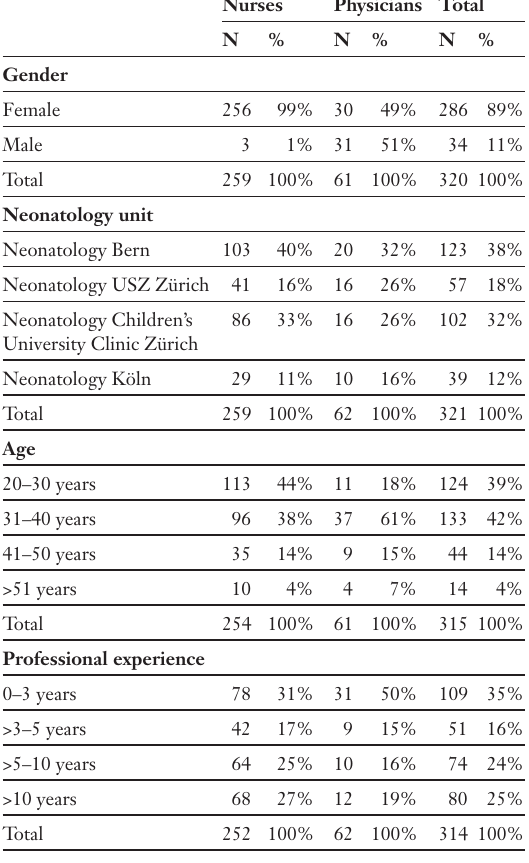
Demographic features of the study sample.